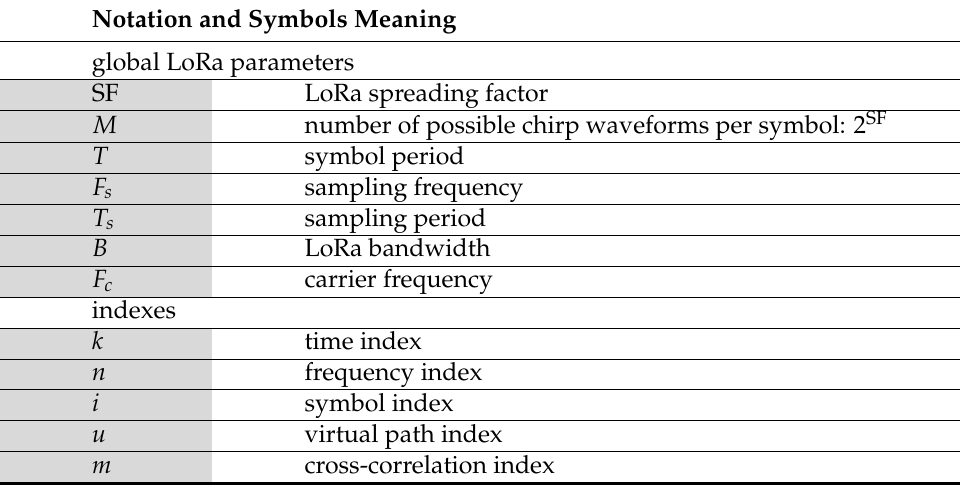
Table 1. List of principal notations used in the